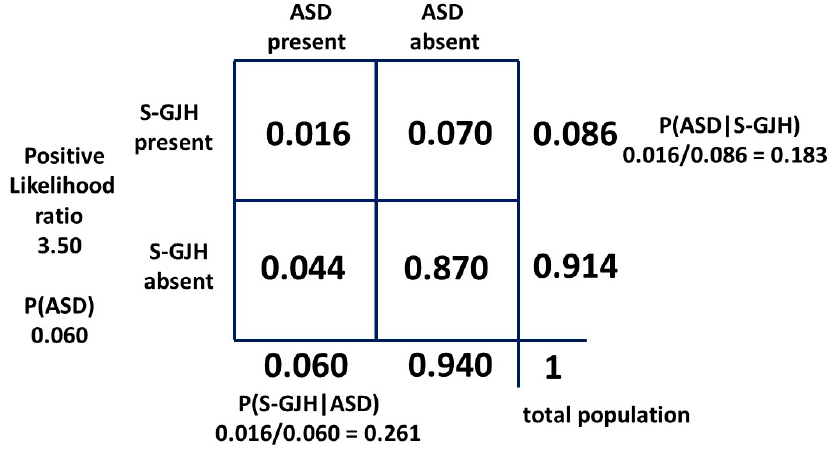
Figure A2. Bayesian 2x2 table for female population ASD/S ‐ GJH as probabilities.